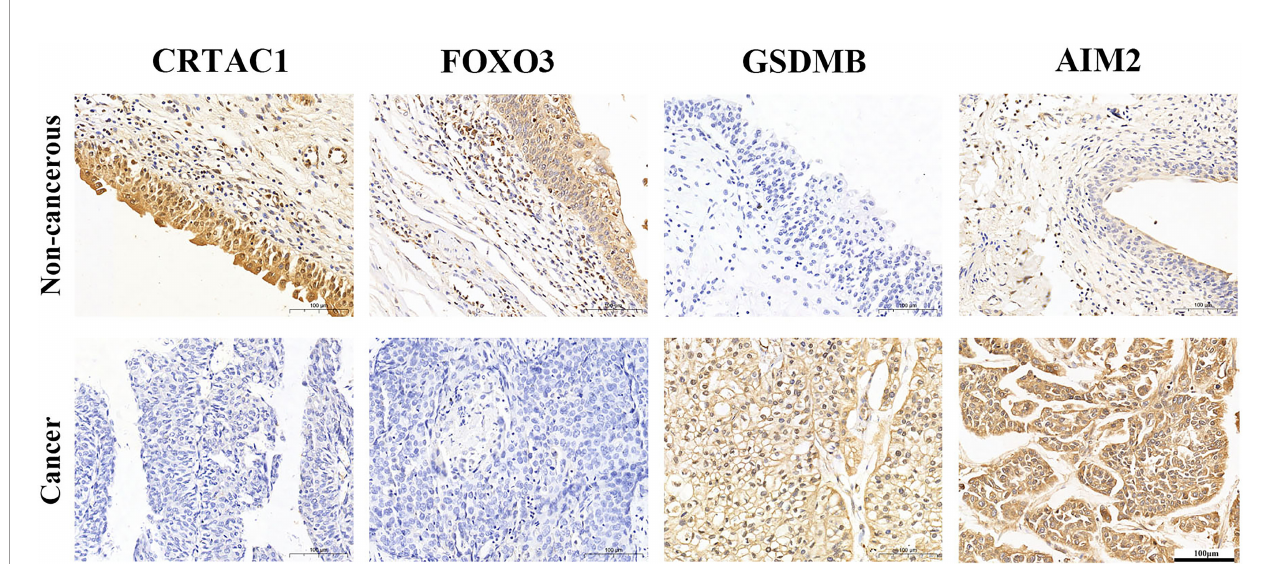
FIGURE 6 | The expression protein of CRTAC1 FOXO3, GSDMB, and AIM2 in BLCA tissues and non-cancerous tissues